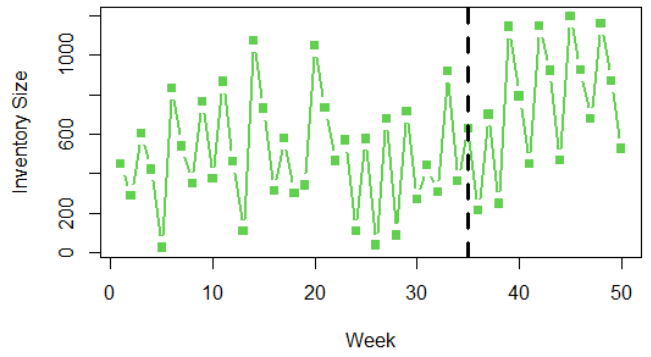
Figure 5. Inventory level according to dynamic plan until week 35.